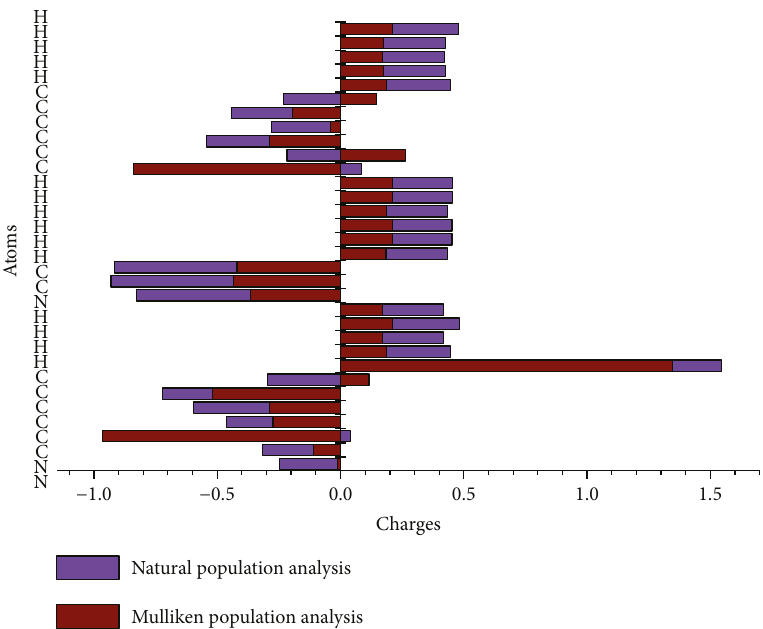
Figure 7: The population distribution graph of DMAB at DFT/B3LYP/6-311G++; comparison of electrostatic charge distribution, natural population analysis, and Mulliken charge distribution in the gas phase.